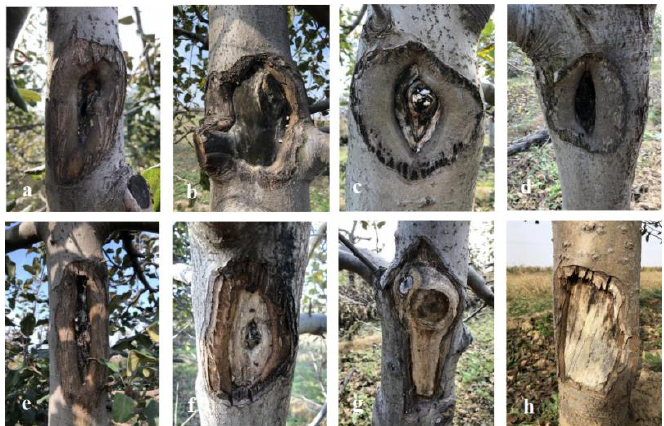
Figure 8. Field efficacy of wood tar on Valsa canker: ( a – f ) pictures of the diseased parts of the trunk in 2021; ( g , h ) field pictures of control in 2021.